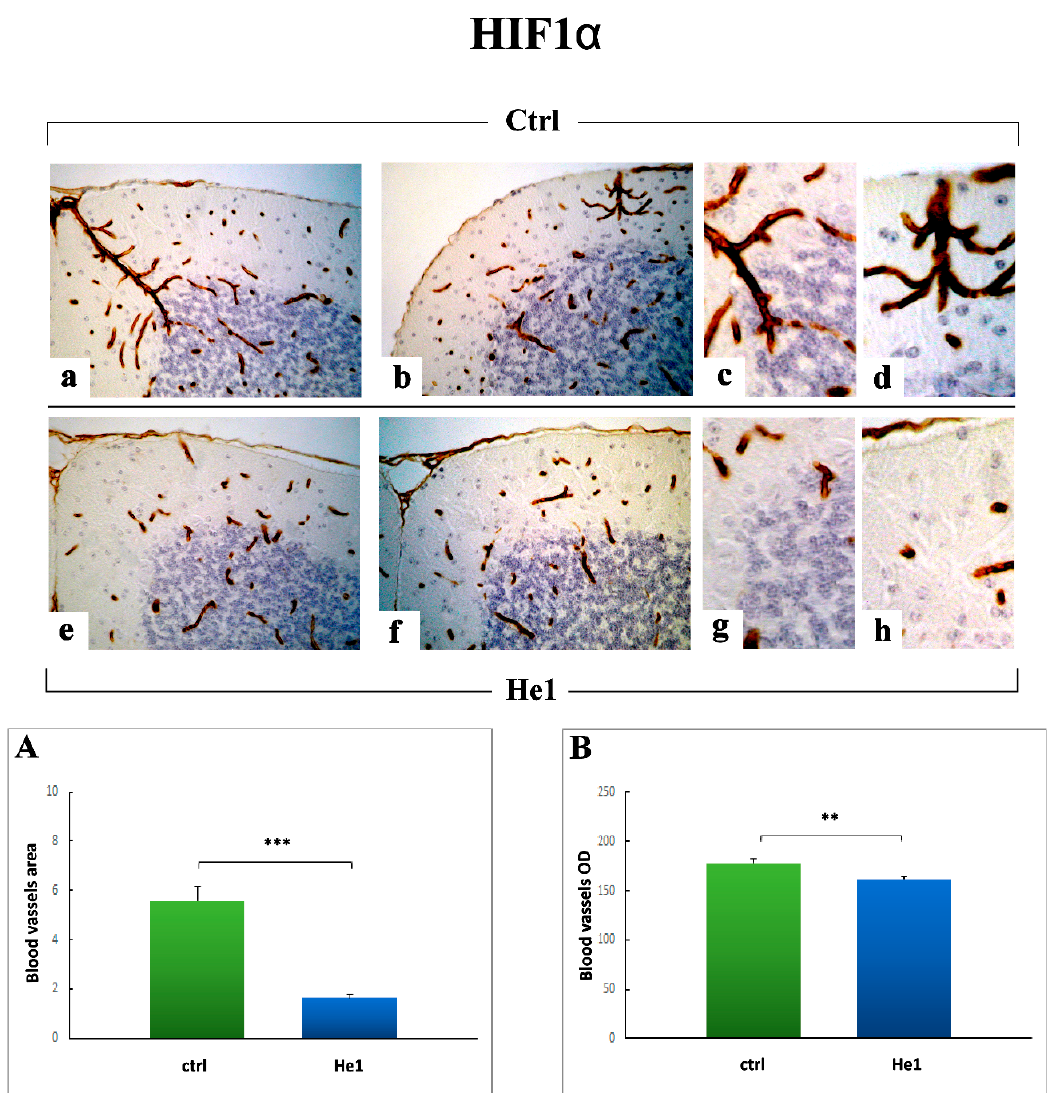
Figure 9. HIF1 α DAB-immunostaining reaction in untreated ( a – d ) and He1-treated mice ( e – h ). Light microscopy magnification: 40× ( a , b , e , f ); 100× ( c , d , g , h ). Panels ( A , B ) Histograms showing HIF1 α -immunopositive blood vessels area and OD, respectively. p values calculated by unpaired Student’s t -test: ** p < 0.05, *** p < 0.001.